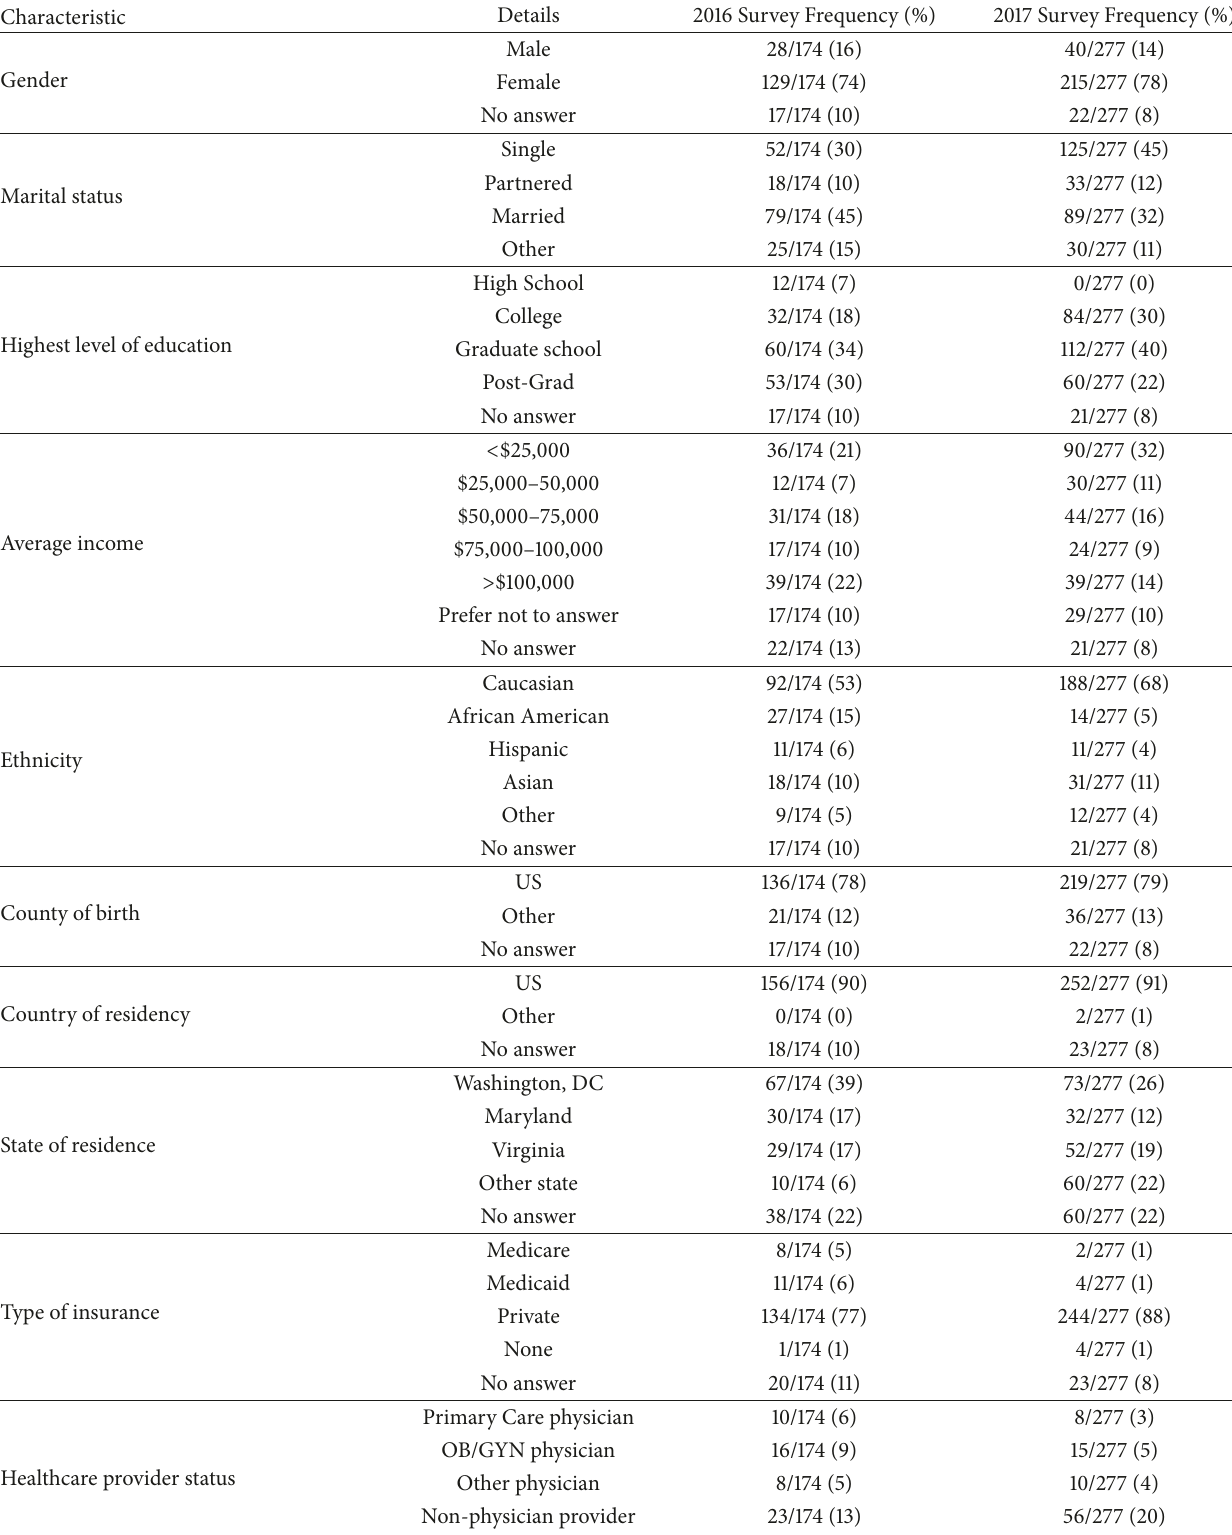
Table 1: Demographic characteristics of survey